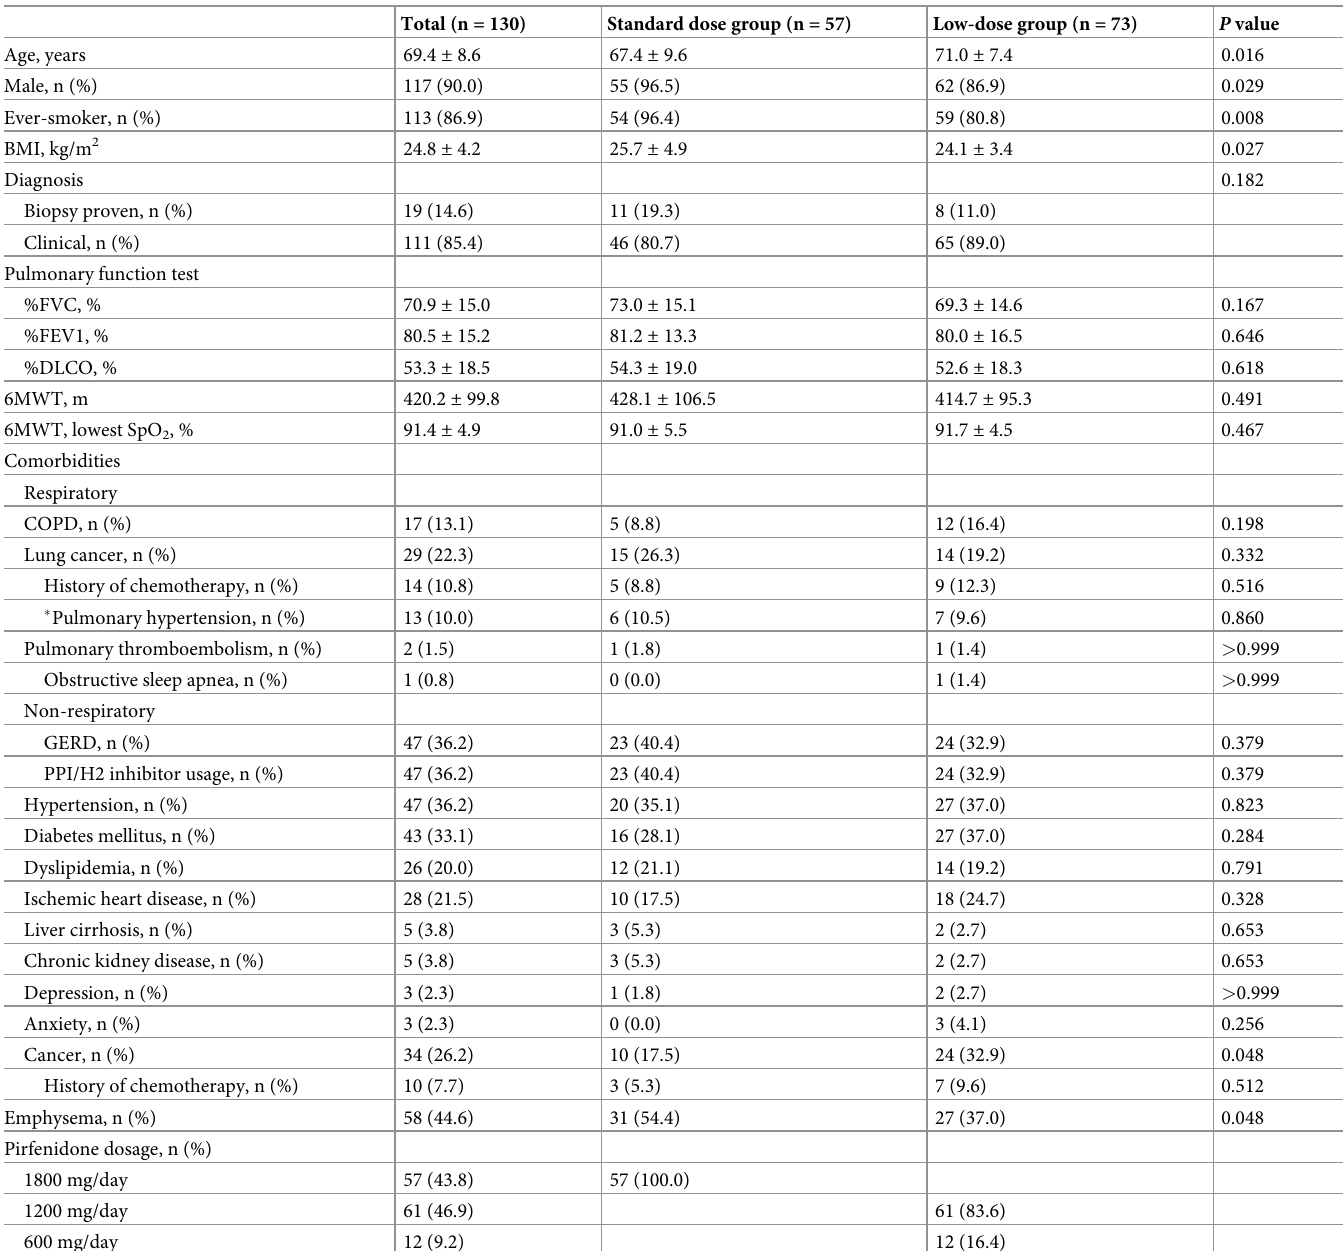
Table 1. Baseline patient